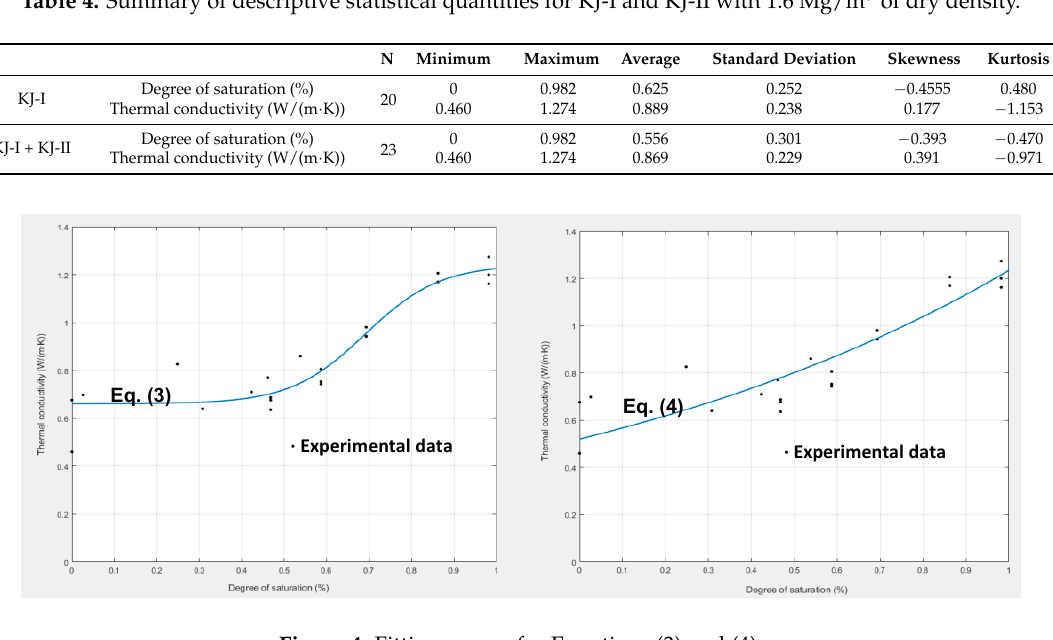
Table 4. Summary of descriptive statistical quantities for KJ-I and KJ-II with 1.6 Mg/m 3 of dry density.